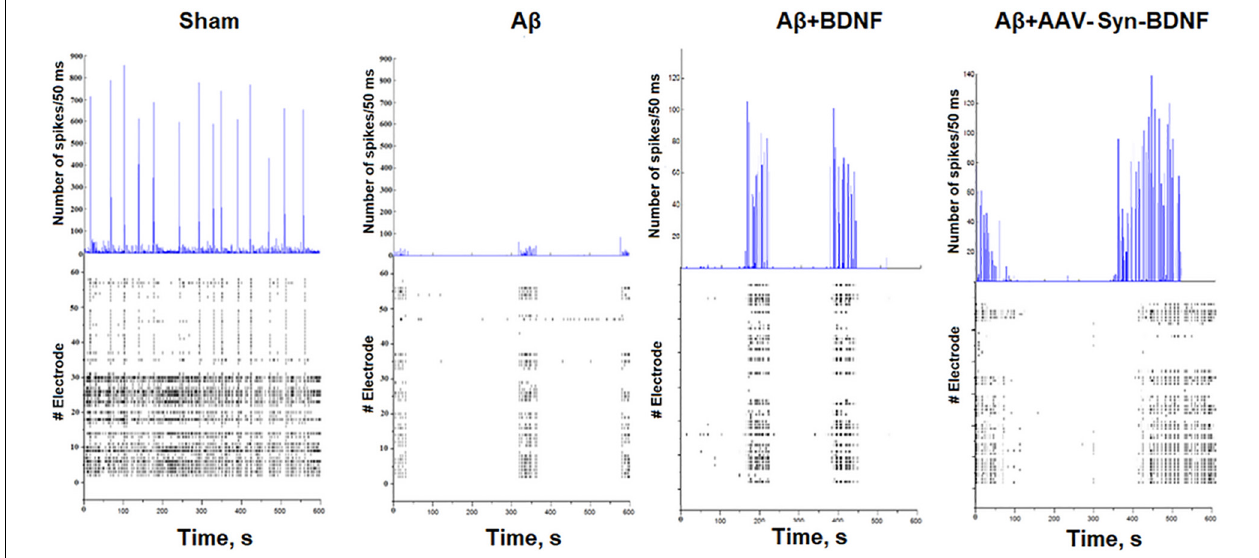
FIGURE 8 | Number of spikes/50 ms and representative raster diagrams of spontaneous bioelectrical activity in primary hippocampal cultures under chronic A β application (DIV 21). The use of A β completely inhibited large network burst formation in cultures until DIV 28. In contrast, in cultures treated with recombinant BDNF and AAV-syn-BDNF the formation of complex network bursts were observed on DIV 21.